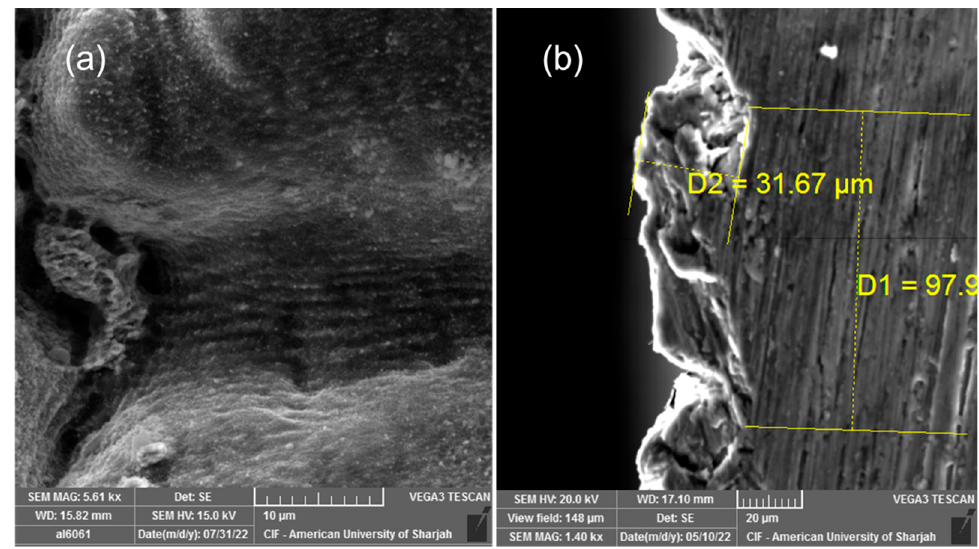
Figure 4. SEM micrograph of the Mo coated on Al 6061 substrate: ( a ) Mo coating with post laser surface treatment with 1.5 W and 0.25 W; ( b ) cross section of the deposited Mo coating over Al 6061 substrate after laser treatment with an average final thickness of D2 of ~30 microns. D1 represents the step size of the laser structuring.